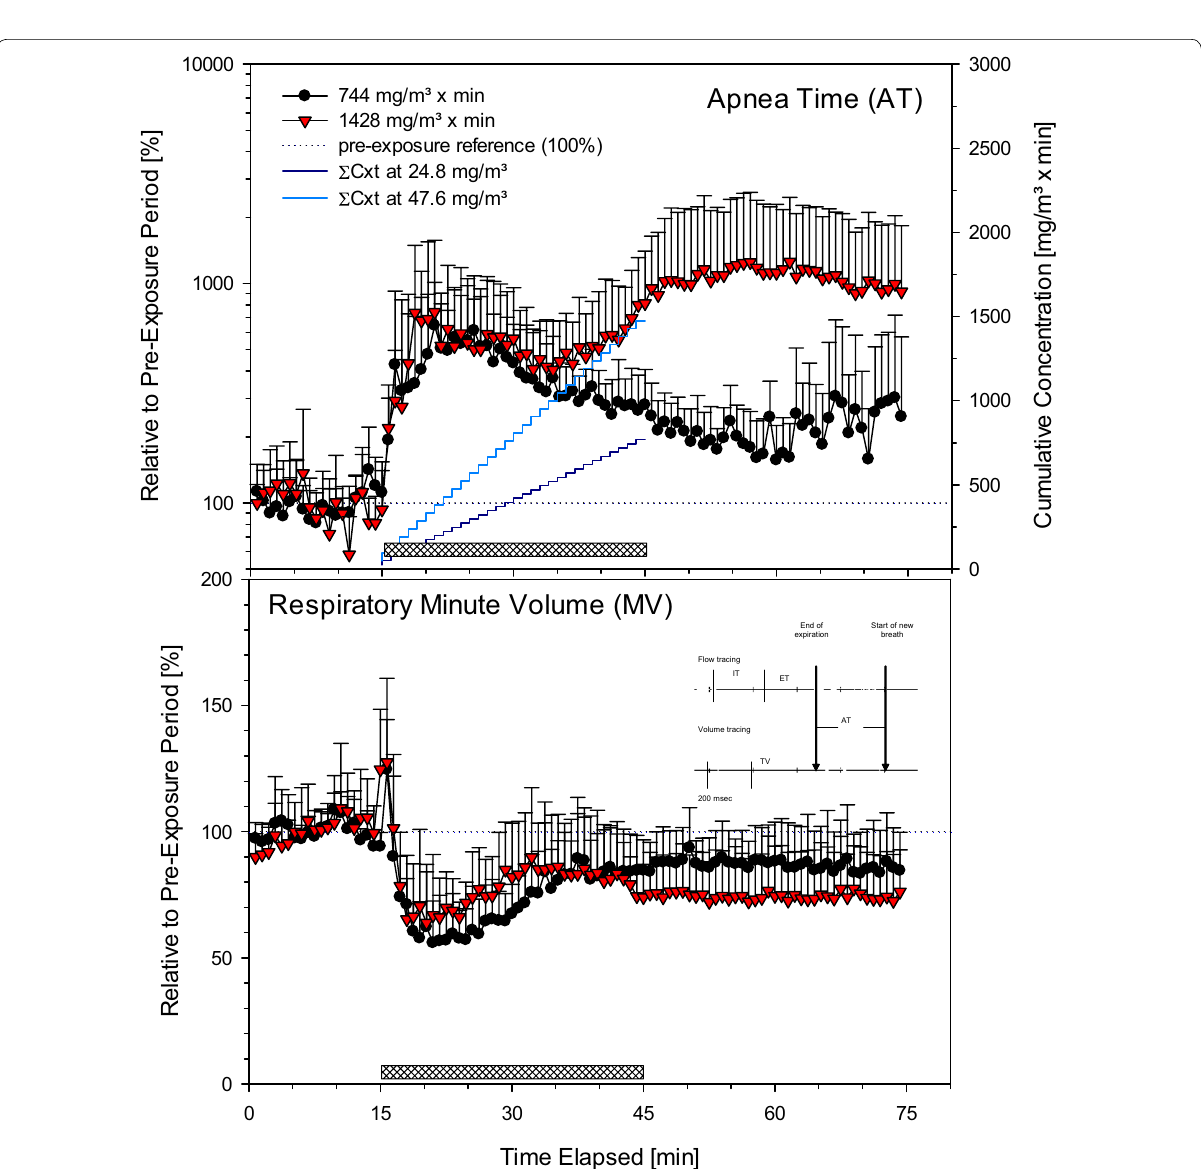
Fig. 1 Analysis of respiratory patterns focused on AT and MV. Measurements were made in conscious, spontaneously breathing restrained rats placed in nose-only volume-displacement plethysmographs (pressure const.). Animals were exposed in three subsequent steps to air (15-min, = pre-exposure baseline data), phosgene (30-min, hatched bar ), and air again (30-min, recovery). Data averaged during time-periods of 45-sec and represent means SDs from eight simultaneously exposed rats/group. The insert given in the lower panel shows two analog tracings that represent + flow-derived ( top ) and integrated volume-derived ( bottom ) changes, respectively. X-axis: 200 ms/tick. The breath structure is characterized by three phases: IT, ET and AT. These phases are used to distinguish between upper airway respiratory tract irritants (bradypnea period between IT and ET; not observed) and lower respiratory tract irritants (apnea period between end of ET and start of new breath). Such pauses do not occur in air only exposed rats. The integrated volume over flow of one breath was the tidal volume (V T ). The product of number of breaths (respiratory rate) V T was × taken as the respiratory minute volume. The stepped curves represent the accumulated Cxt over the duration of exposure to